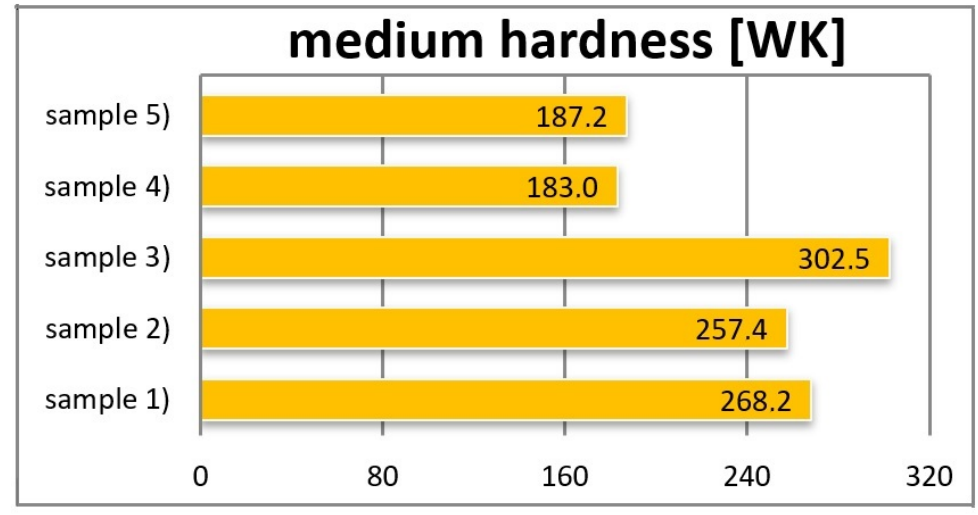
Figure 9. Medium hardness of samples.